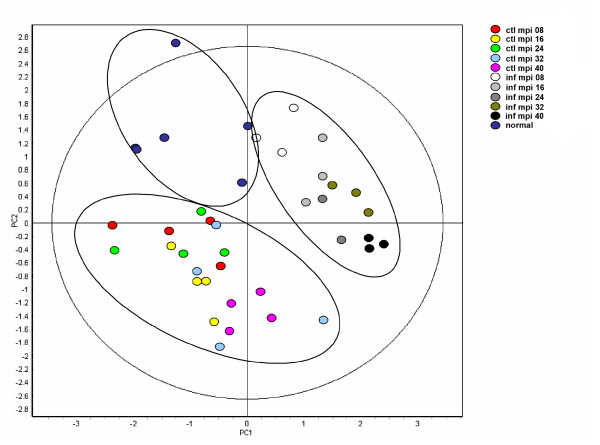
Principle component analysis of different disease states followed throughout the disease progression. Ellipses have been drawn to illustrate the clustering of the 3 groups (BSE infected, control and normal). Within the infected group it can also be seen that the individual time points cluster together. A somewhat similar but less pronounced pattern is observed in the control samples. This analysis is based on the 56 spot features exhibiting statistically significant (ANOVA p < 0.01) changes in abundance and present on all 40 gel images. (PC1 = 38.6, PC2 = 23.0).